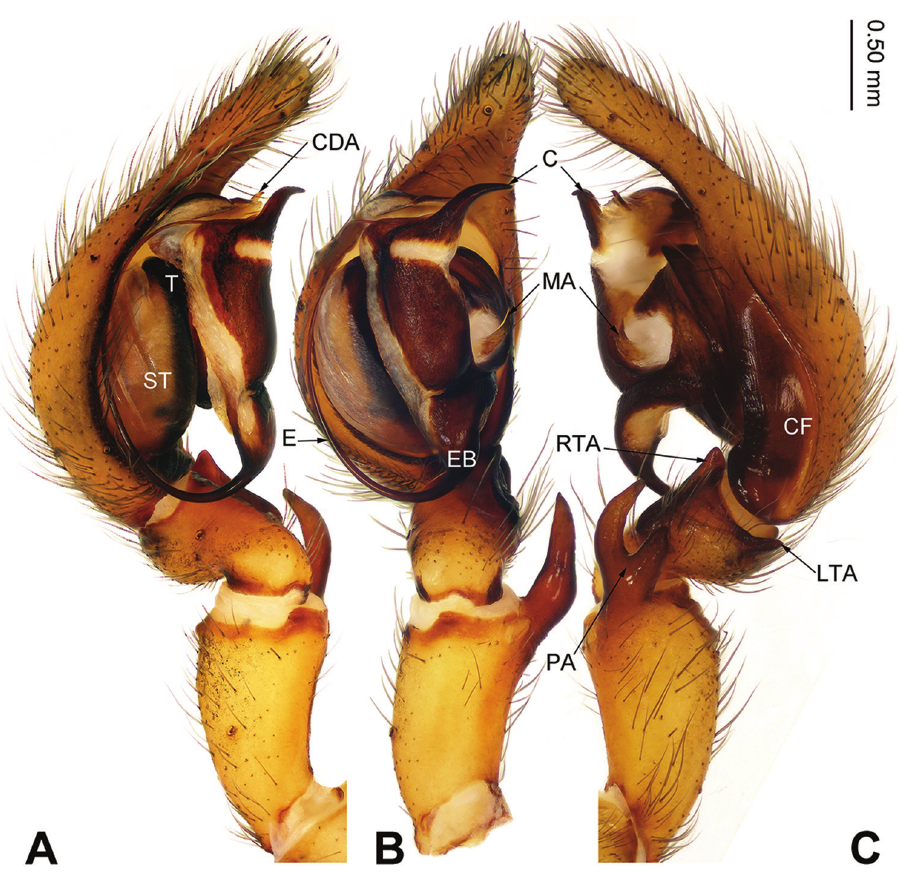
Figure 1. Left male palp of Sinodraconarius sangjiuensis sp. n., holotype. A Prolateral view B Ventral view C Retrolateral view. Scale bar: equal for A, B, C